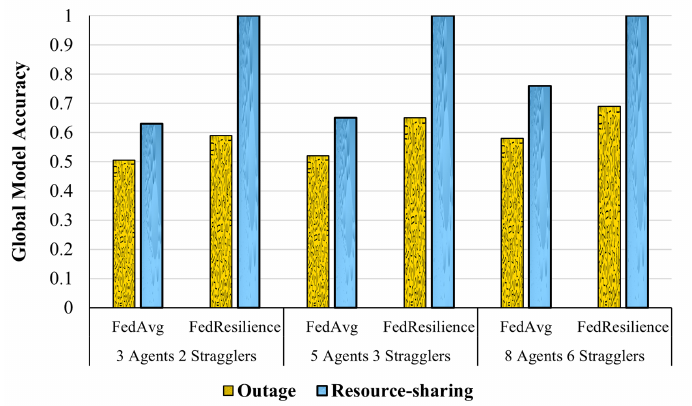
Figure 27. Comparison of global model accuracy of FedAvg and proposed FedResilience in the presence of stragglers.